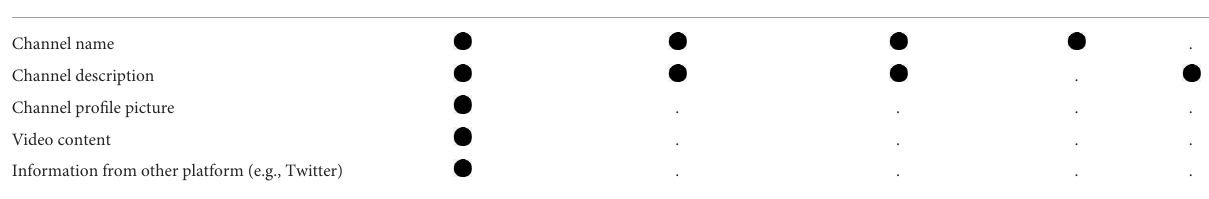
TABLE 1 Information regarded in single classification